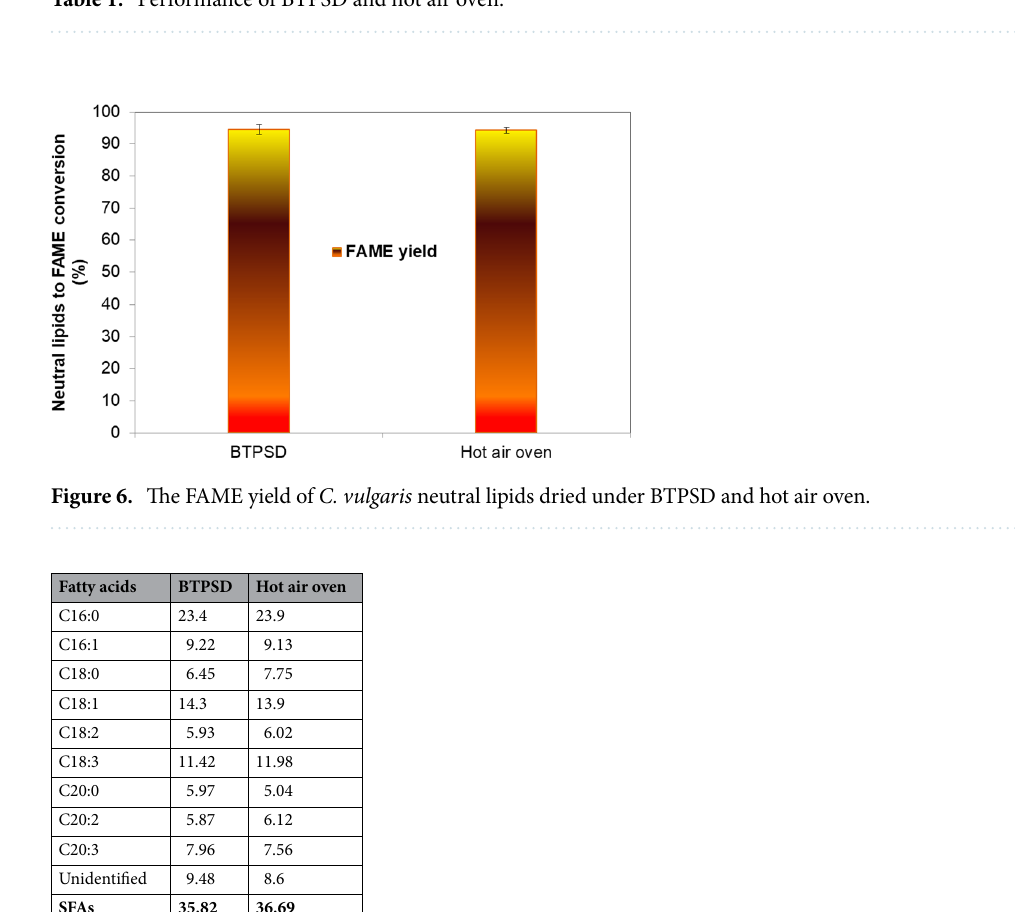
Table 1. Performance of BTPSD and hot air oven.